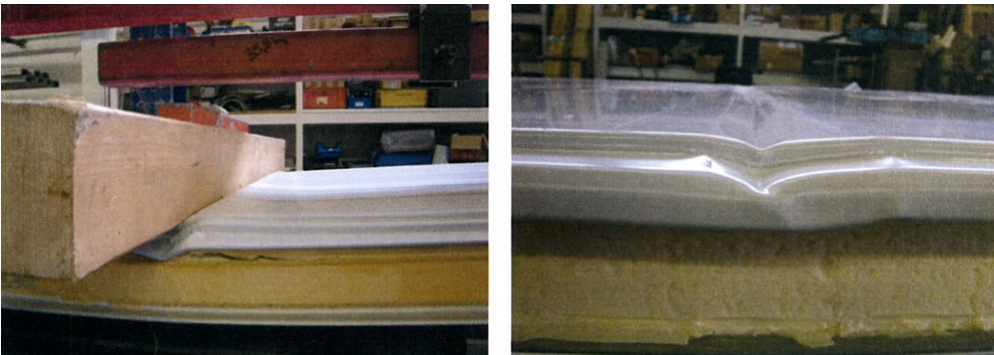
Fig. 9 Compressive failure of face sheet (crumpling); glass ply is bonded to bottom face sheet.